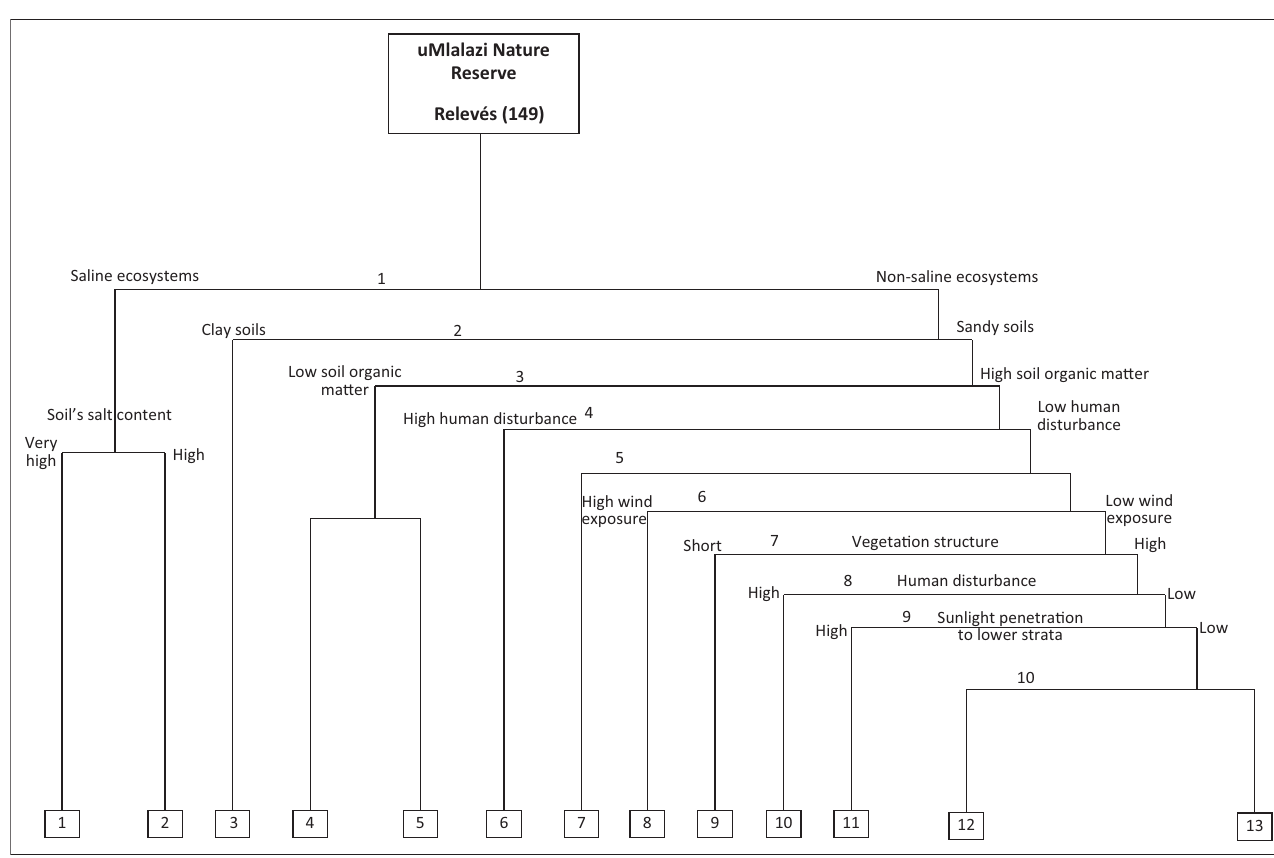
Low LowLow High